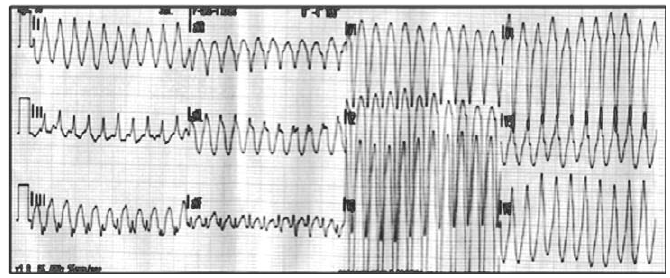
Figure 4 . Electrocardiogram of a 56-year-old previously healthy man with chest pain and shortness of breath that started while he was